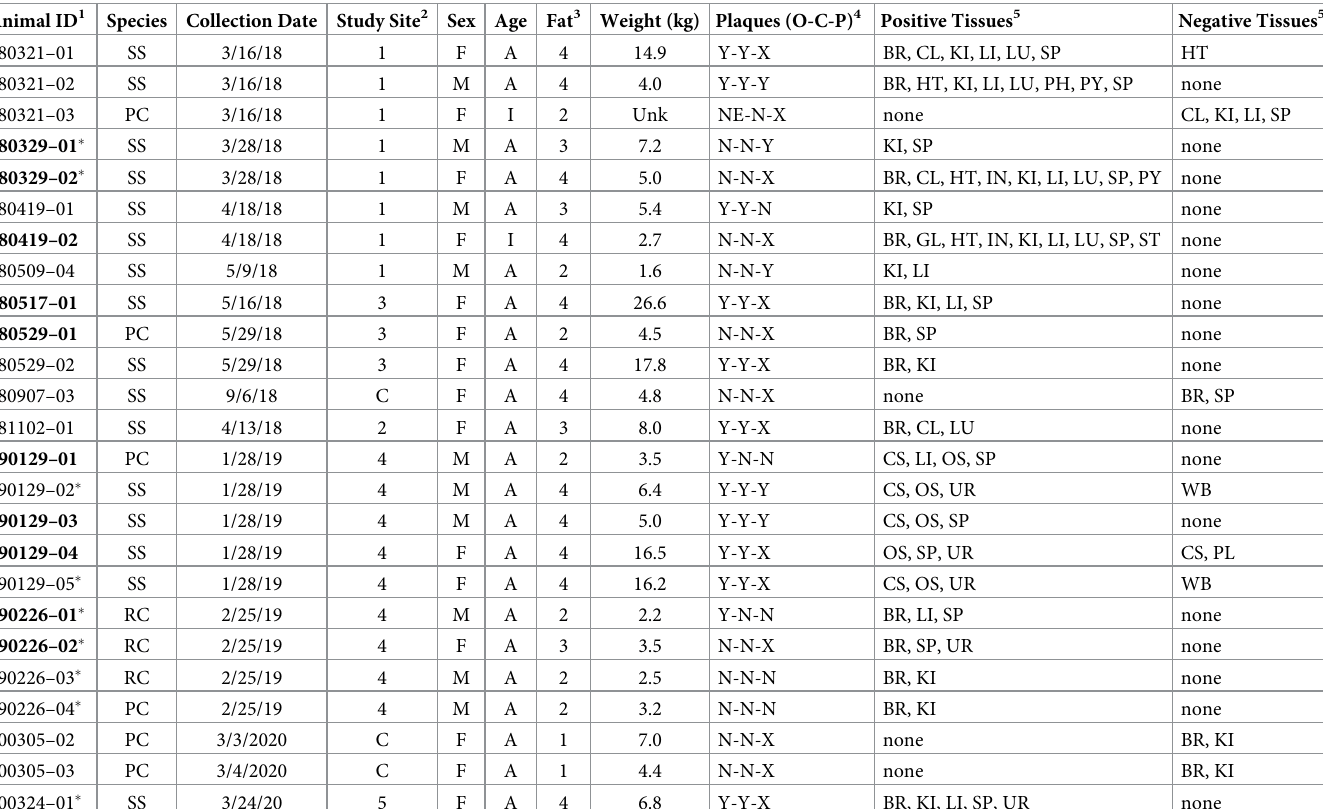
Table 2. Necropsy and conventional TFV1 RT-PCR results for 25 free-ranging freshwater turtles, where SS = Florida Softshell ( Apalone ferox ), PC = Peninsula Coo- ter ( Pseudemys peninsularis ), and RC = Florida Red-Bellied Cooter ( Pseudemys nelsoni ). Ages are represented as adult (A) and immature (I); sexes as female (F) and male (M). Corresponding information for each study site is described in Table